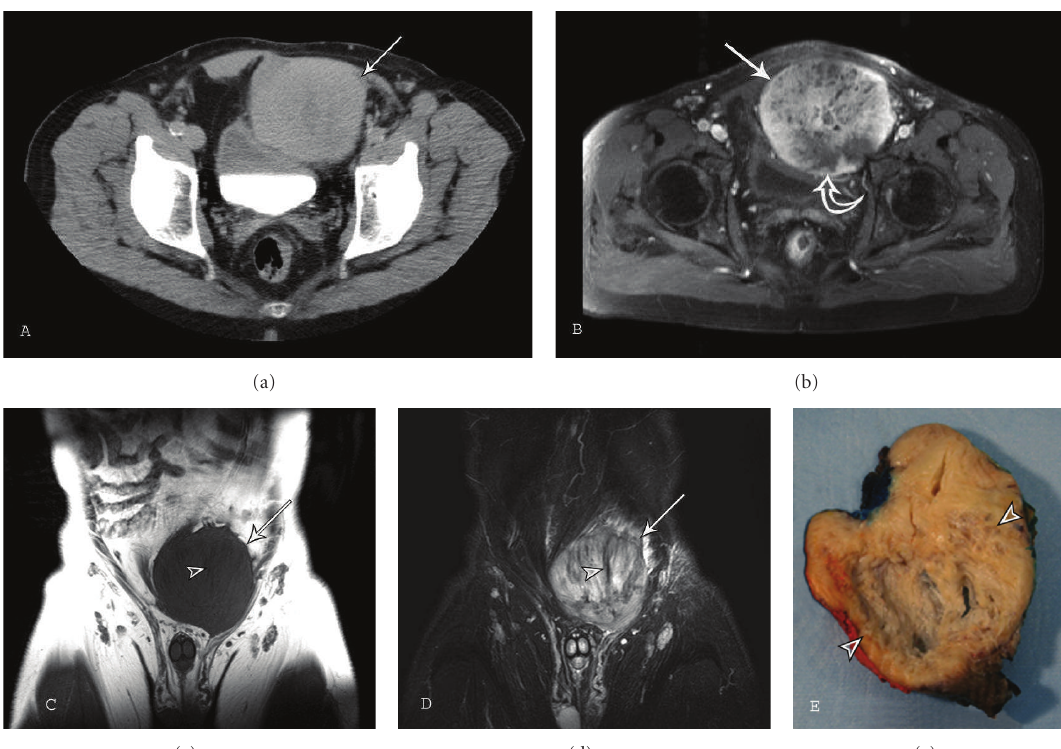
Figure 10: Abdominal fibromatosis: a 65-year-old male with a slowly growing painless suprapubic mass. (a) Axial CT and T1 (TE13/TR643) fat saturation image postcontrast reveal a well-defined soft-tissue mass (arrows) in the lower left rectus abdominis that displaces the bladder to the right. Lesion attenuation on CT is higher than skeletal muscle reflecting higher collagen component. An area of necrosis (curved arrow in (b)) is noted in the posterior aspect of the lesion. Lesion margins and heterogeneous enhancement are better appreciated on MR. (c) Coronal T1-weighted (TE11/TR427) and (d) STIR (TE78/TR4810) sequences show the lesion (arrows) with mildly ill-defined borders, mild peripheral edema, and band-like areas (arrowheads) of low signal within the lesion. (e) Photograph of the sectioned gross specimen, resected after radiation therapy, reveals a large area of central necrosis